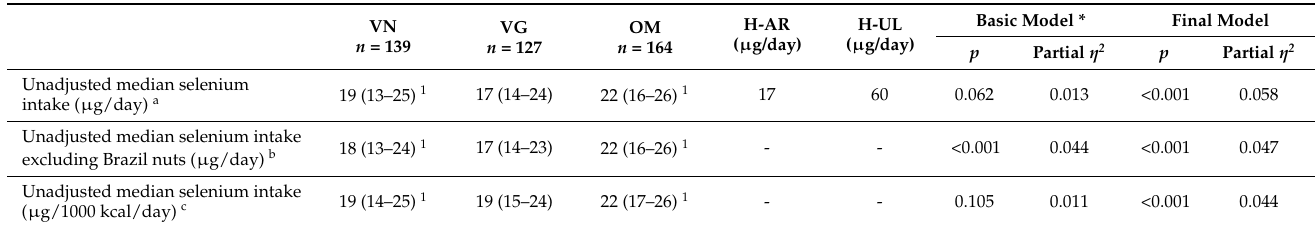
Table 1. Median daily selenium intake among 1- to 3-year-old children by dietary group compared with the H-AR and